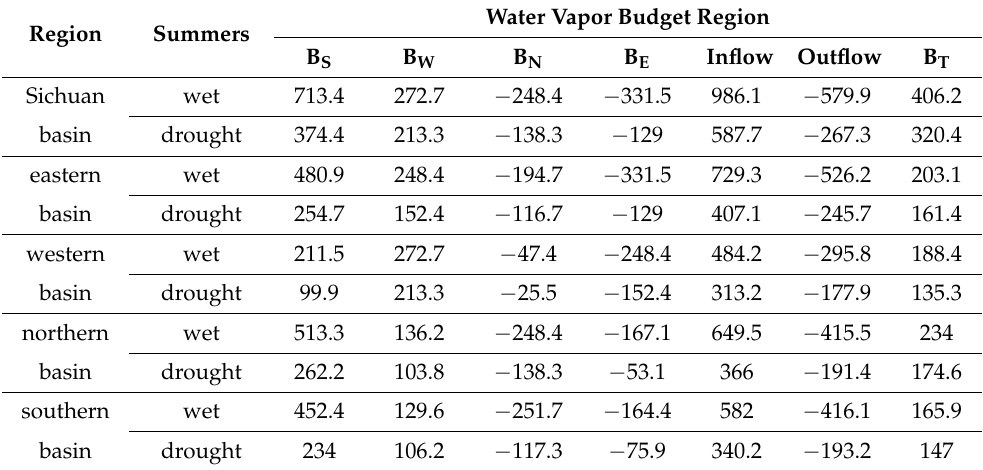
Table 3. The water vapor flux, total inflow, total outflow, and net budget at each boundary of the Sichuan Basin in the wet and drought summers (unit: 10 6 kg s − 1 ).